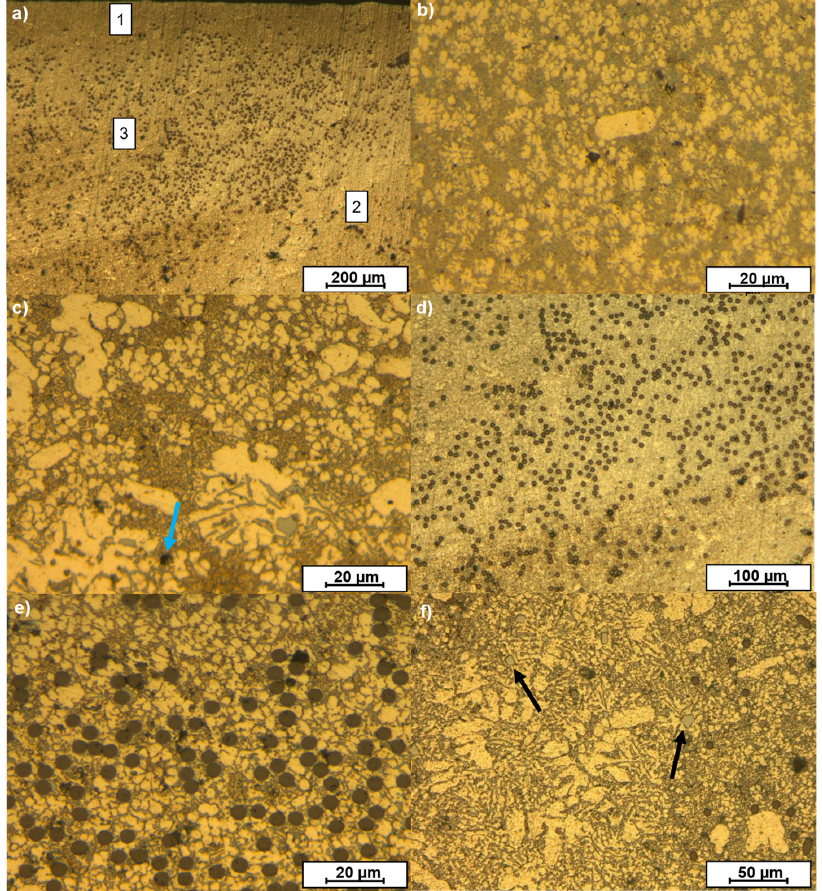
Figure 5. Microstructure of the sample obtained by optical microscopy: ( a ) general view of the cross-section of a sample reinforced with woven: zone 1 corresponds to the microstructure close to the die; zone 2 to the microstructure far from the die and the fibers and zone 3 to the microstructure close to the fiber; ( b ) zones in contact with the mold; ( c ) zones far from the mold and the fibers with arrowed pore; ( d ) samples with reinforcement in zones near the fibers; ( e ) magnification of ( d , f ) zones with arrowed α-AlFeMnSi phases.